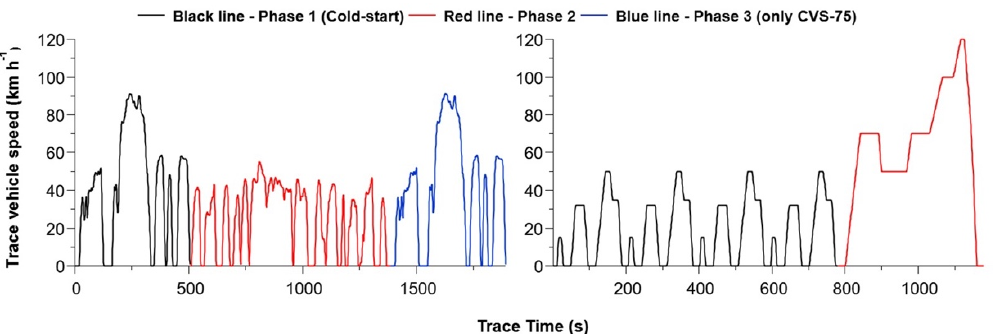
Figure 2. Regulation modes used in measurement. CVS-75 mode used in gasoline, LPG, and diesel vehicles for EURO 3. NEDC mode used in diesel vehicles after EURO 4.